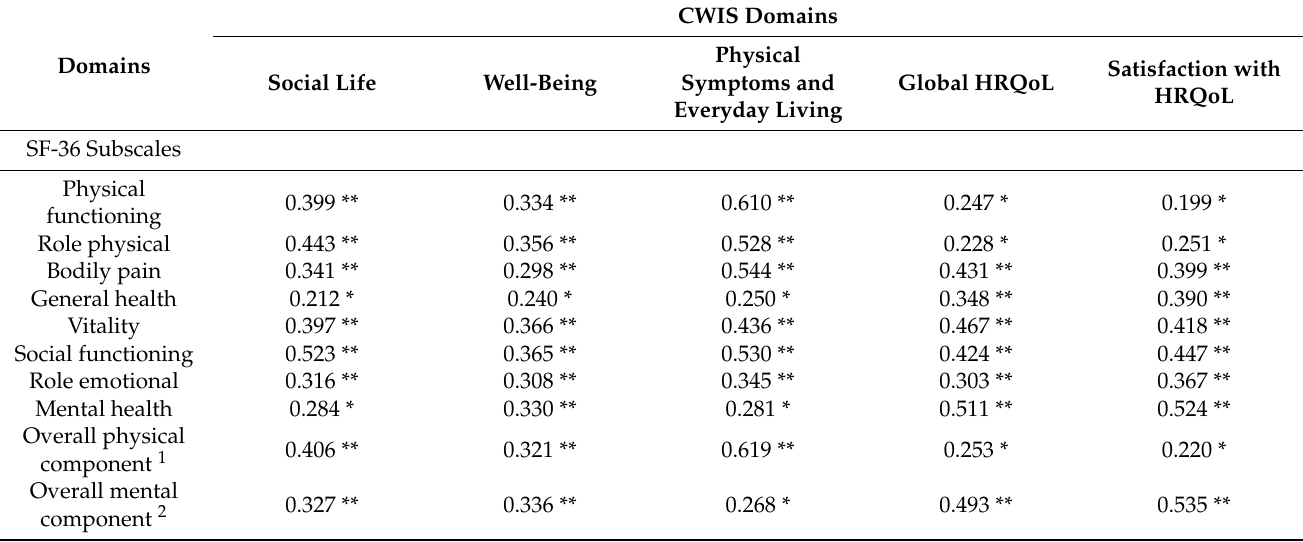
Table 3. Linear regression between domains of the Cardiff Wound Impact Schedule (CWIS) and the SF-36 and EQ-5D overall and subscale